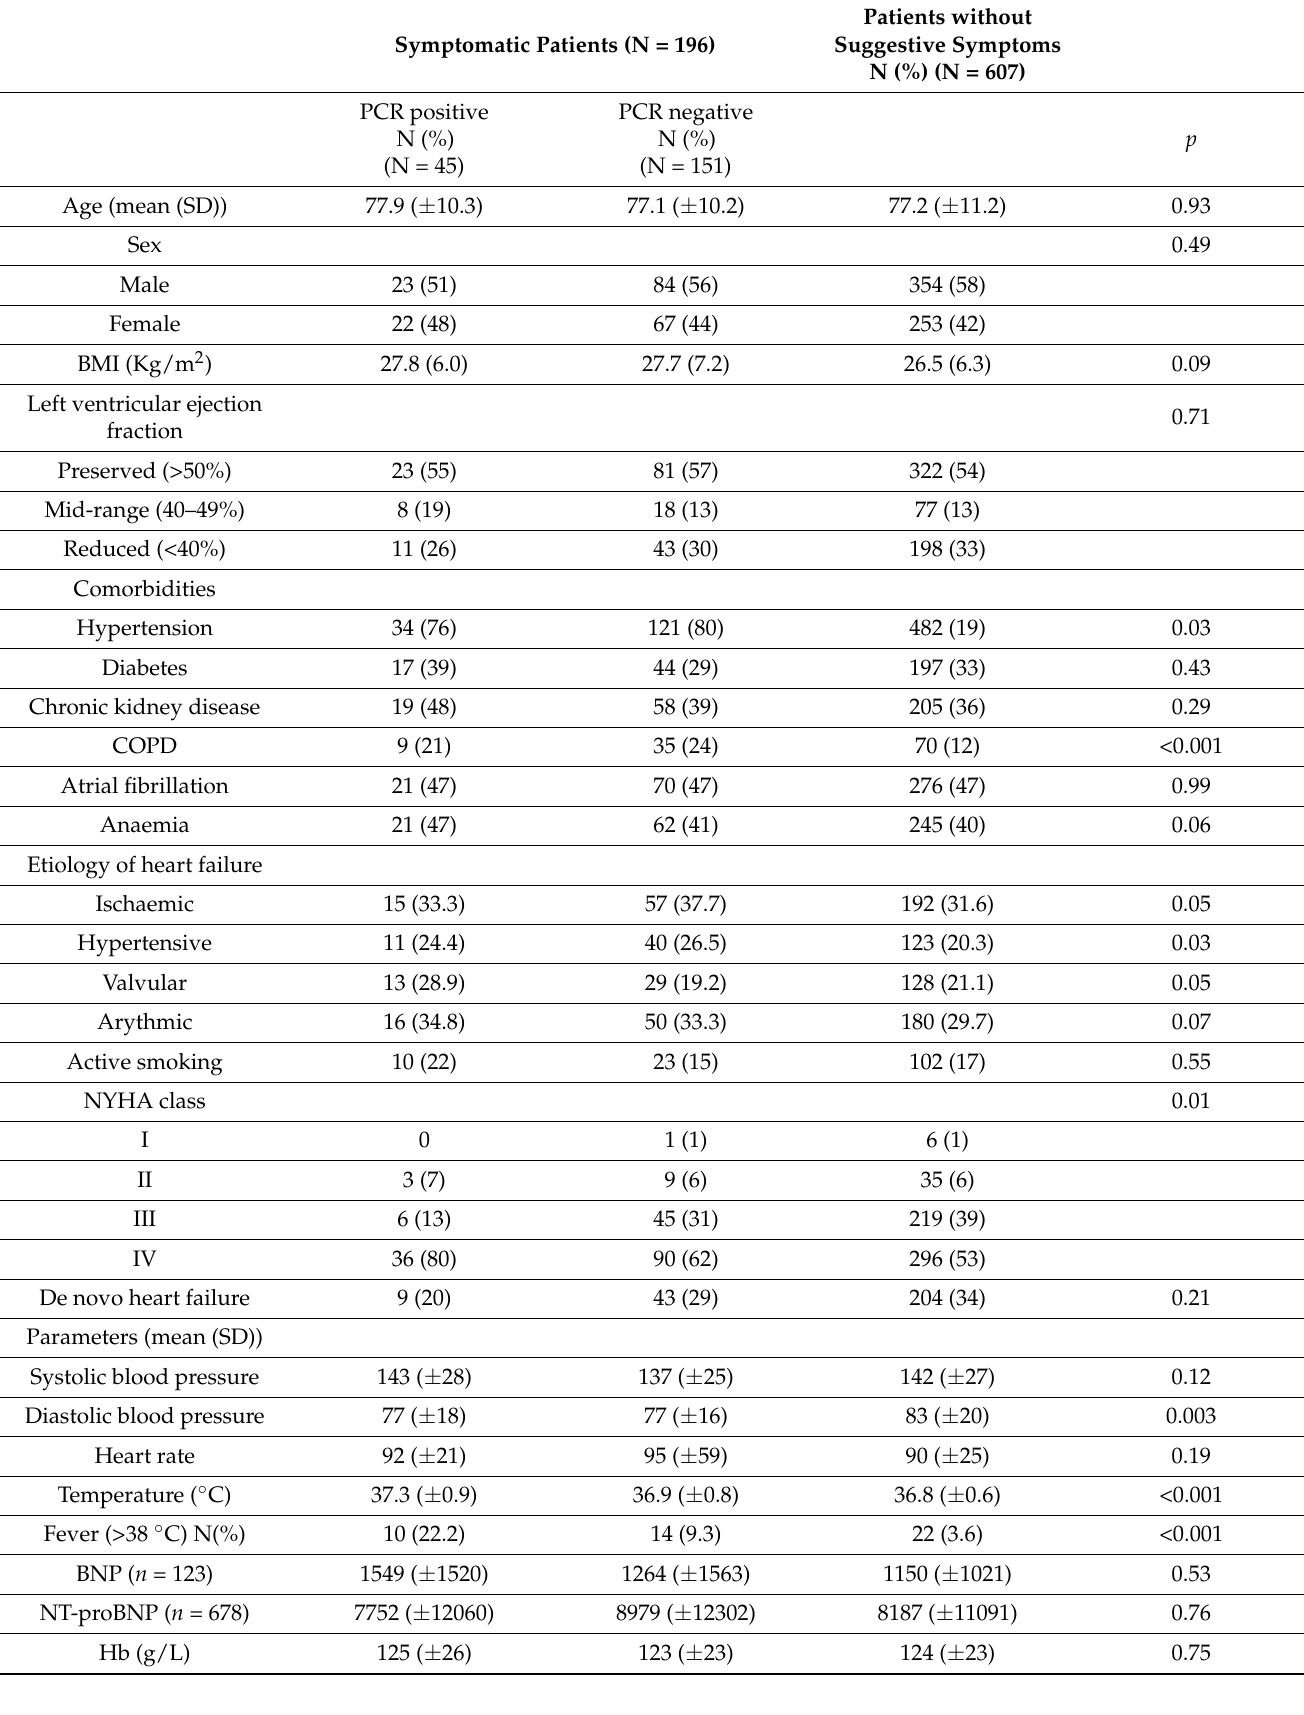
Table 1. Baseline